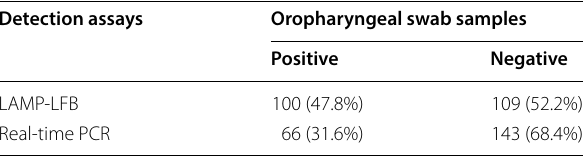
Data were presented as number (%)